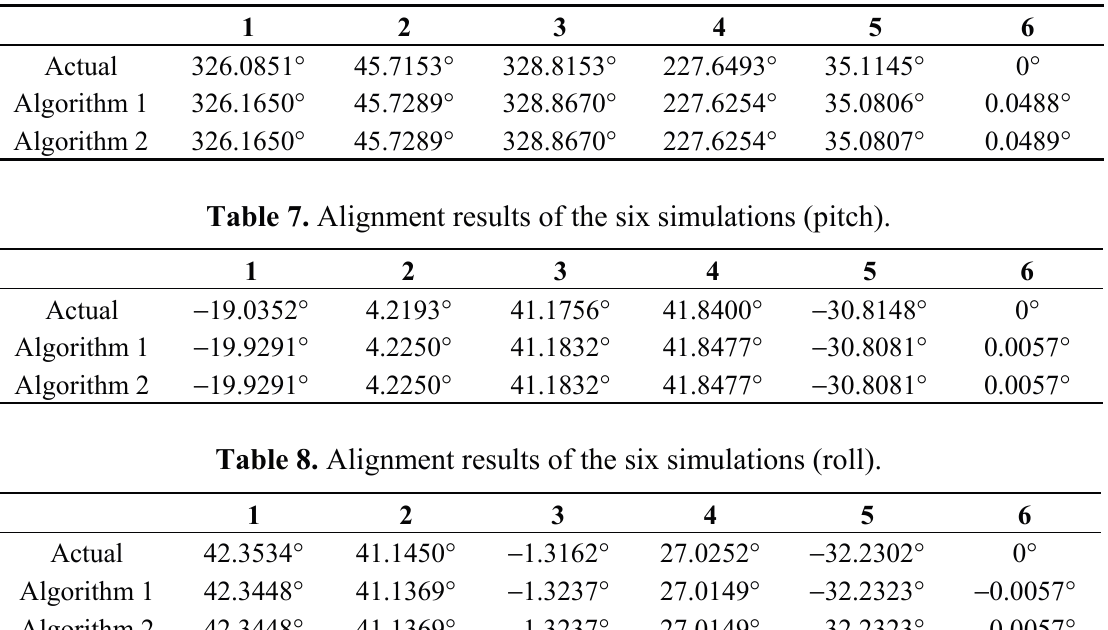
Table 6. Alignment results of the six simulations (heading).